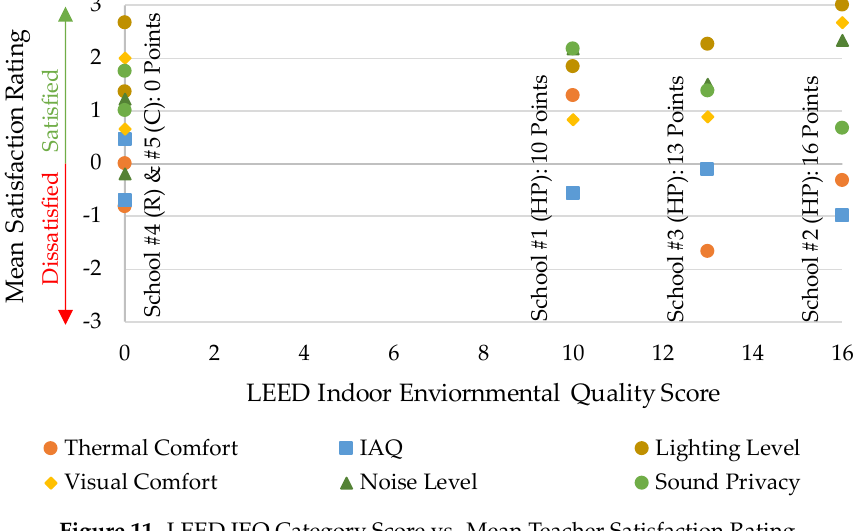
Figure 10. LEED IEQ Category Score vs. Mean Quantitative IEQ Metrics During Occupied Hours.